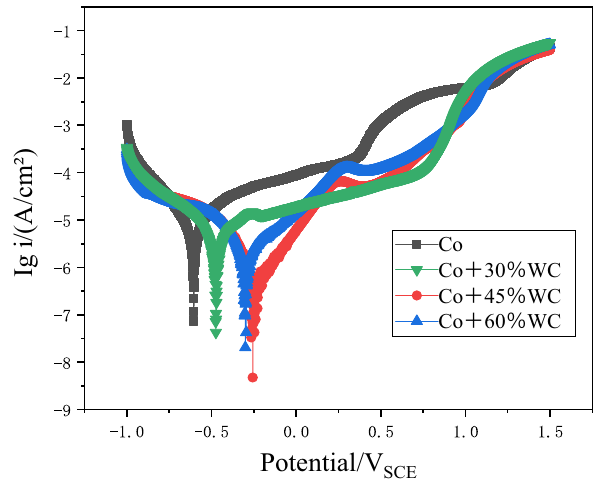
Figure 8: Potentiodynamic polarization curves of Co - WC coatings and pure Co coating in 3.5 wt% NaCl solution.